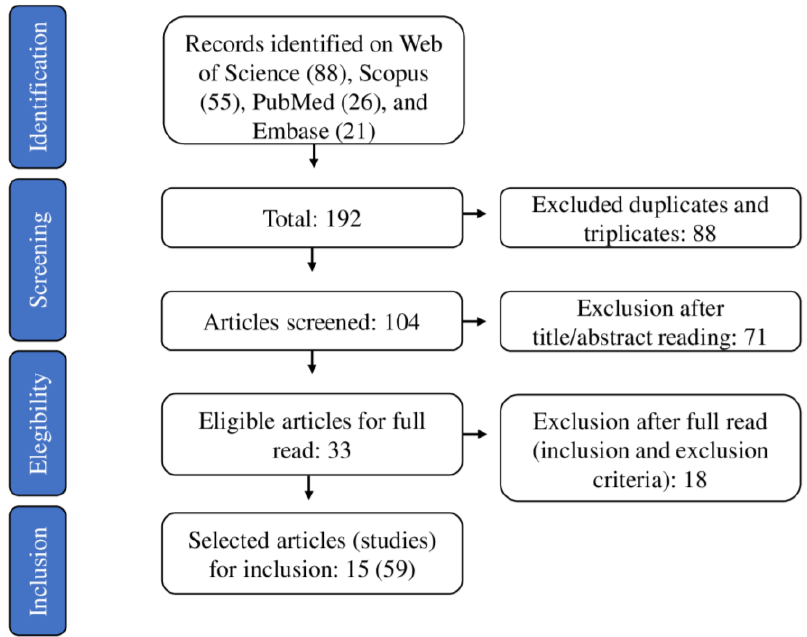
Figure 1. PRISMA flowchart for the search, selection, and inclusion of the studies.